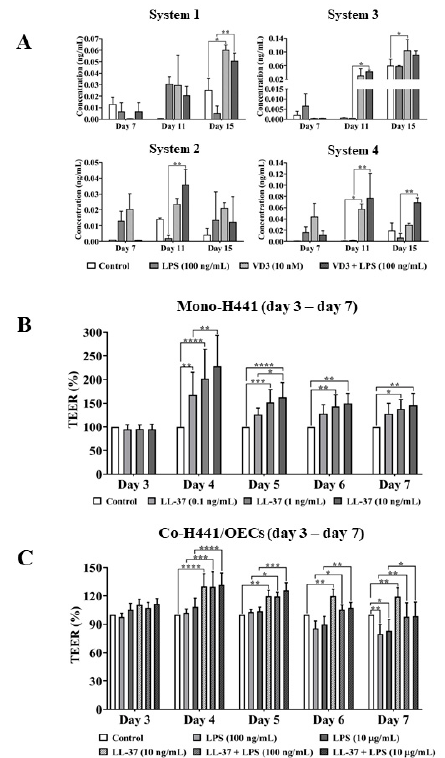
Figure 6. The secretion levels of LL-37 in NCI-H441 cells and its e ff ect on the barrier properties. ( A ) LL-37 secretion of NCI-H441 cells from four individual modi fi ed mono-cultures of NCI-H441 cells with VD 3 (10 nM) and LPS (100 ng/mL) treatments ( n = 4). The cell culture period was extended to 15 days, and the medium supernatants were collected on day 7, 11, and 15, with medium exchange every 4 days. ( B ) TEER measurement from day 3 to day 7 of the mono-culture of NCI-H441 cells grown on the apical side of the Transwell ® fi lters. The 1 µM dexamethasone and LL-37 treatments were applied from day 3 to day 7 with di ff erent doses (0.1 ng/mL, 1 ng/mL, 10 ng/mL). ( C ) TEER measurement from day 3 to day 7 of the co-culture of NCI-H441/OECs in the Transwells ® . The cells were pretreated with LL-37 (10 ng/mL) and 1 µM dexamethasone on day 3 and treated with LPS (100 ng/mL, 10 µg/mL) on day 5 from the basolateral compartments for 48 h. The measured TEER values were analyzed as relative ratios in percentage (%) in comparison with the control group. The values were shown as mean values ± SD from at least four independent experiments ( n ≥ 4). * p ˂ 0.05, ** p ˂ 0.01, *** p ˂ 0.001, **** p ˂ 0.0001, one- and two-way ANOVA.